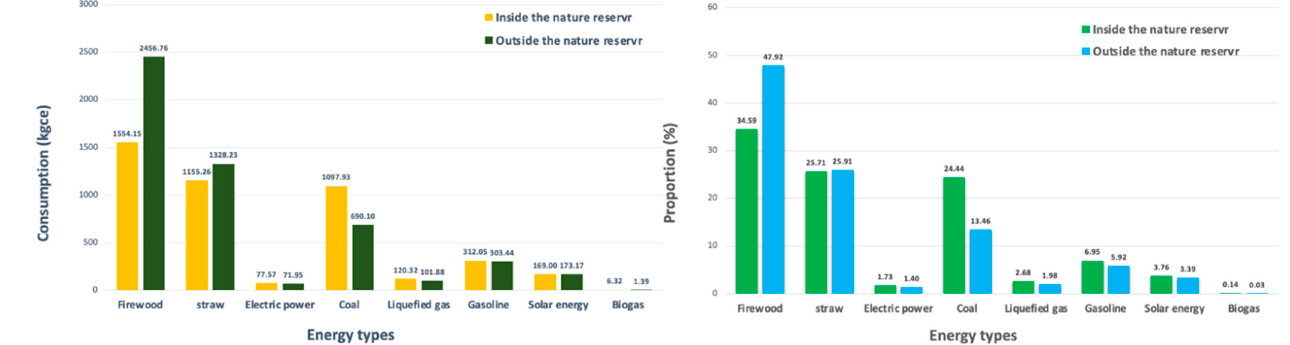
Figure 3. Energy consumption (average quantity) rates of rural households in and outside nature reserves.